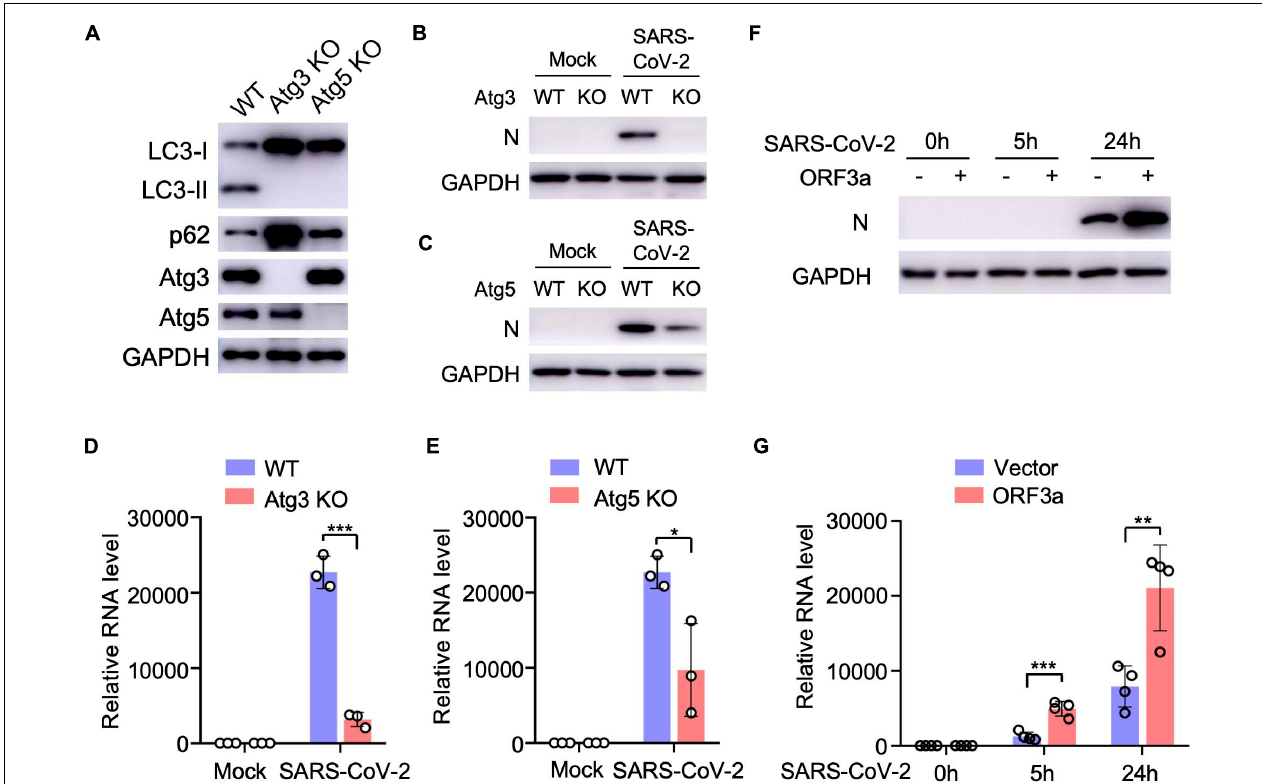
FIGURE 3 | Cellular autophagy is required for efficient SARS-CoV-2 replication. (A) Genetic abrogation of Atg3 or Atg5 blocks autophagy response in MEF-hACE2 cell lines. (B–E) Atg3 or Atg5 KO reduces SARS-CoV-2 replication efficiency in MEF-hACE2 stable cells. MEF-hACE2 WT , MEF-hACE2 Atg 3 KO , or MEF-hACE2 Atg 5 KO were infected with SARS-CoV-2 (MOI = 1) and virus replication was examined by IB of viral N protein (B,C) or quantitative RT-PCR of viral transcripts (D,E) . (F,G) ORF3a expression facilitates SARS-CoV-2 replication. Calu3-vector or Calu3-ORF3a stable cells were infected with SARS-CoV-2 (MOI = 1) and virus replication was examined by IB of viral N protein (F) or quantitative RT-PCR of viral transcripts (G) . Mean ± SEM; n = 3 (D,E) or n = 4 (G) ; ns, not significant, * p < 0.05; ** p < 0.01; *** p < 0.001 by Student’s t